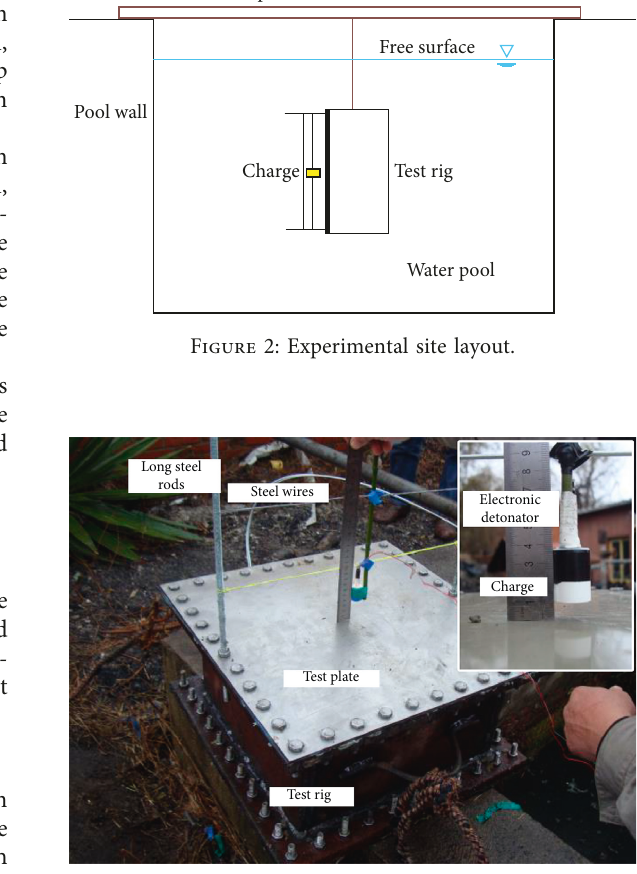
Figure 3: Details of the test